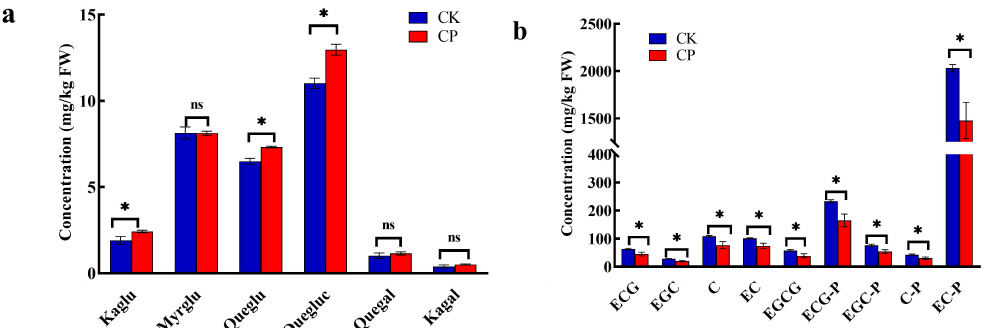
Figure 5. Significantly influenced flavonoid compounds by covering purslane in the harvest grapes in the year 2018. ( a ) flavonols of grape berry skins; ( b ) flavanols of grapes berry seeds. Flavonols: Kaglu, kaempferol-3- O -glucoside; Myrglu, myricetin-3- O -glucoside; Queglu, quercetin-3- O -glucoside; Qugluc, quercetin-3- O -glucuronide; Qugal, quercetin-3- O -galactoside; Kagal, kaempferol-3- O -galactoside. Flavanols: ECG, ( − )-epicatechin-3- O -gallate; EGC, ( − )-epigallocatechin; C, (+)-catechin; EC, ( − )-epicatechin; EGCG: ( − )-epigallocatechin-3- O -gallate; -P, extension subunits; without -P, Free monomers. * indicates significant differences between the control and covering purslane ( p < 0.05, t -test), ns, not significant.